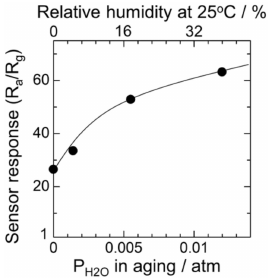
Figure 6. The sensor response to 200 ppm hydrogen at 350 ◦ C in dry atmosphere as a function of P H2O in